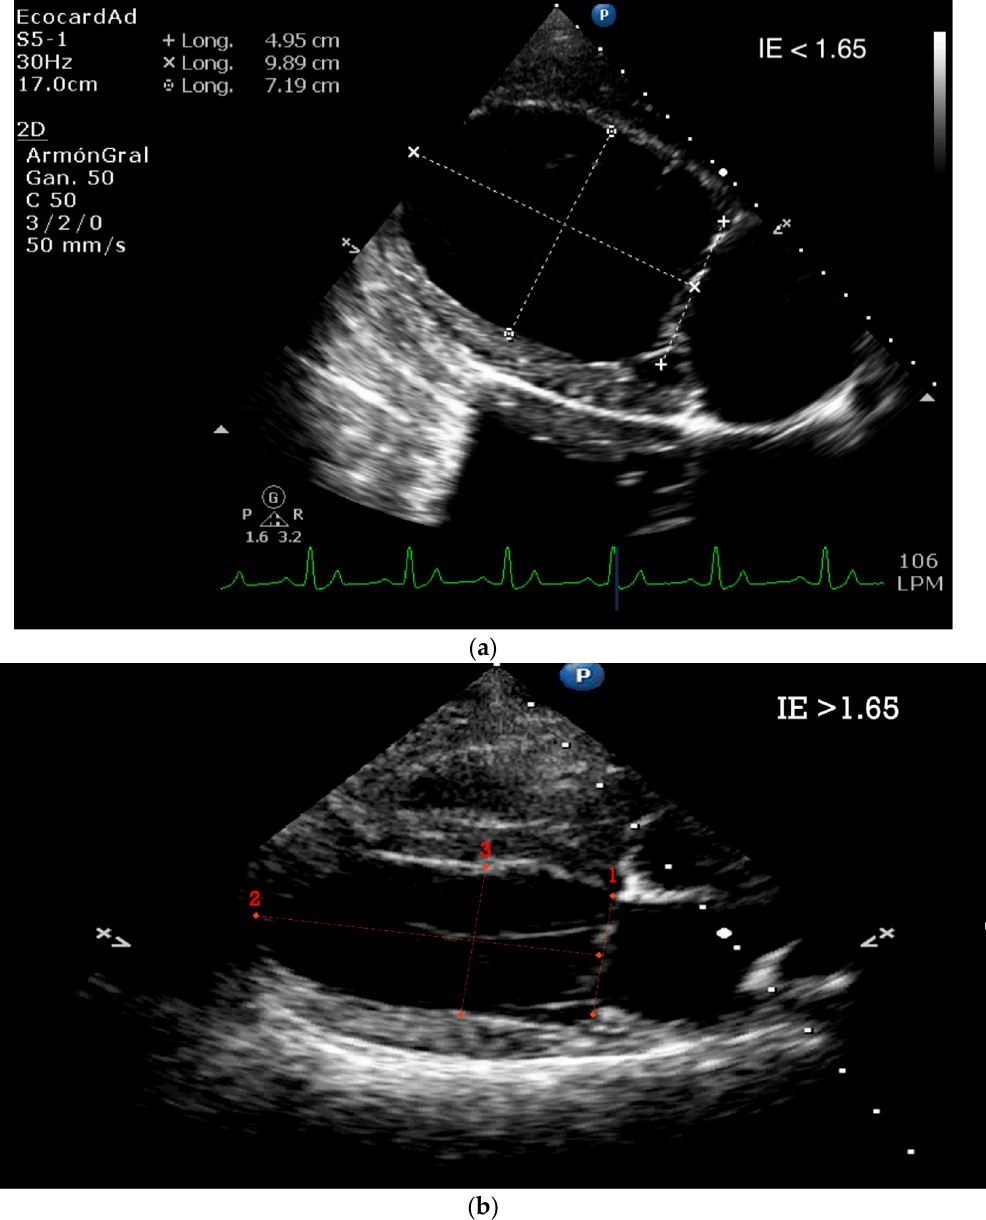
Figure 16. ( a ). Decreased Sphericity Index in canine patient. ( b ). Normal Sphericity Index in the canine patient.